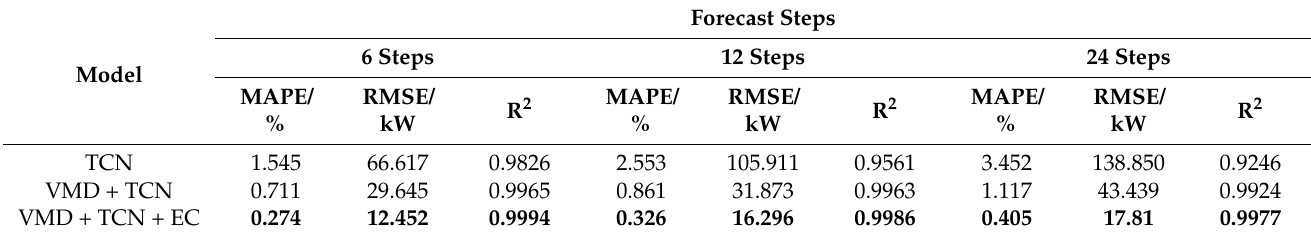
Table 2. Performance evaluations of different models for the GEFCom datasets.